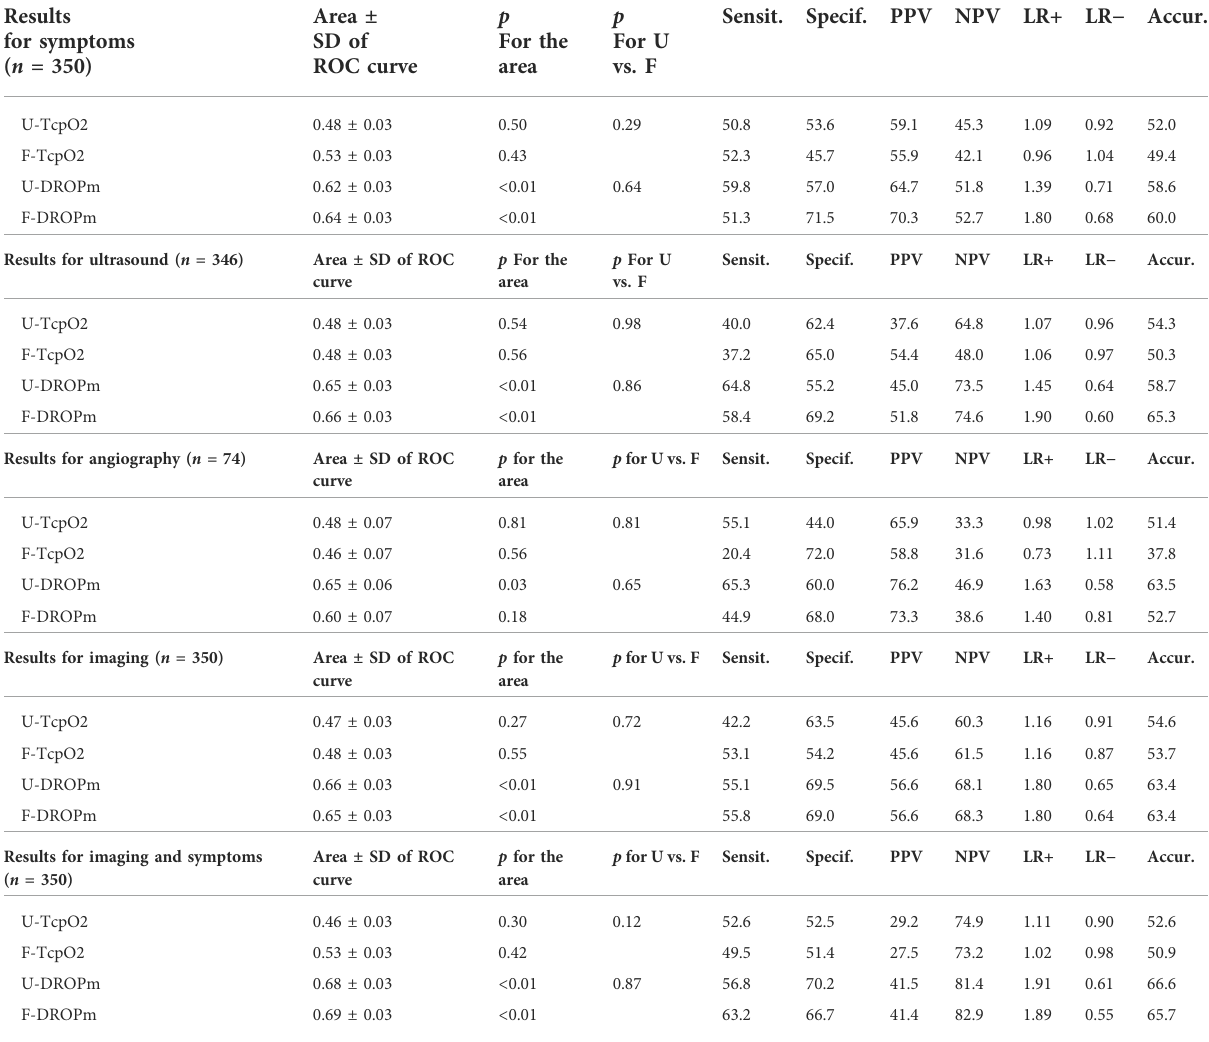
TABLE 3 Area under the ROCcurve for transcutaneous oximetryat rest (TcpO2) and during the Ca- Pra maneuvre (DROPm) at the forearm and upper arm levels, for detecting the presence of symptoms (Symp+), a compression during ultrasound (US+), during angiography (Ang+), or during imaging (Img+): either a positive ultrasound or a positive angiography, or symptoms with positive imaging (CS+). Note that for ultrasounds and angiography, the numbers of observations are only 346 and 74 respectively. Numbers in parentheses are the number of upper limbs in each group. p fortheareaiscomparisonfromarandomchoice. ” p forUvs.Fisthecomparisonbetweenupper-armandforearmresults.Sensit.Specif.PPV,NPV, LR+, LR − and Accur., are for sensitivity (in %), speci fi city (in %), positive predictive value (in %), negative predictive value (in %), positive likelihood ratio, negative likelihood ration and accuracy (in %),